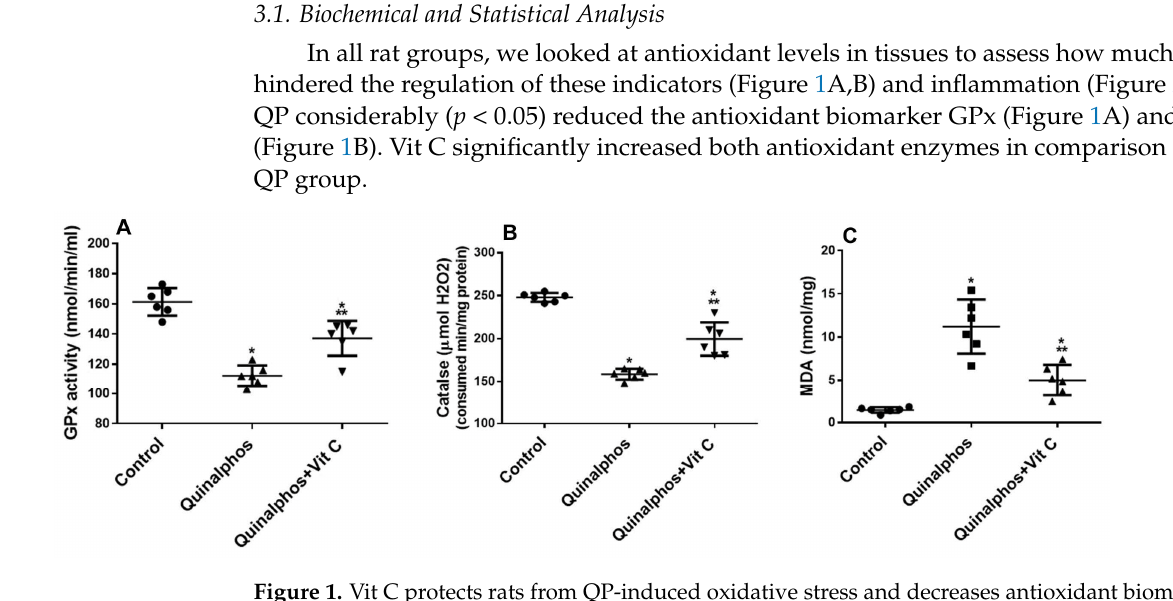
Figure 1. Vit C protects rats from QP-induced oxidative stress and decreases antioxidant biomarkers. At the end of the study, the values of GPx ( A ), CAT ( B ), and MDA ( C ) in heart homogenates were assessed in the three groups of rats included in this study: control, QP, and QP + Vit C. The findings are the mean (±SD) f; n = 6. Experiments were carried out in triplicate. * p < 0.05 in comparison to control group, ** p < 0.05 in contrast to QP group.